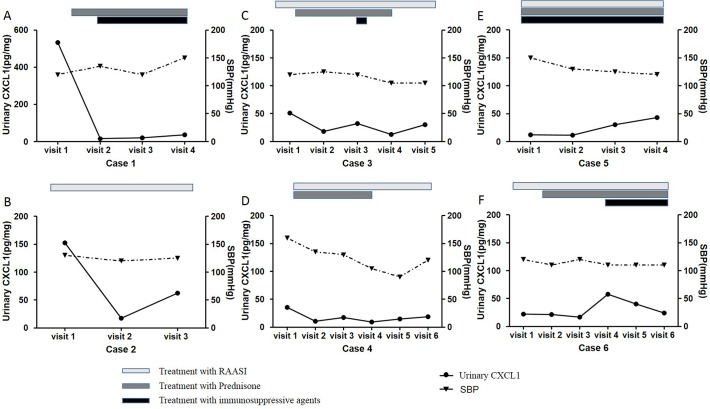
Correlation of urinary CXCL1 level with SBP during follow-up period.The variation tendency of urinary CXCL1 was not the same with that of SBP, not only in patients with high baseline urinary CXCL1 levels (case 1 & case 2, A & B), but also in patients with middle baseline urinary CXCL1 levels (case 3 & case 4, C & D) and patients with low baseline urinary CXCL1 levels (case 5 & case 6, E & F). Treatments are depicted as grey-level-coded bars, on behalf of the period of using time.